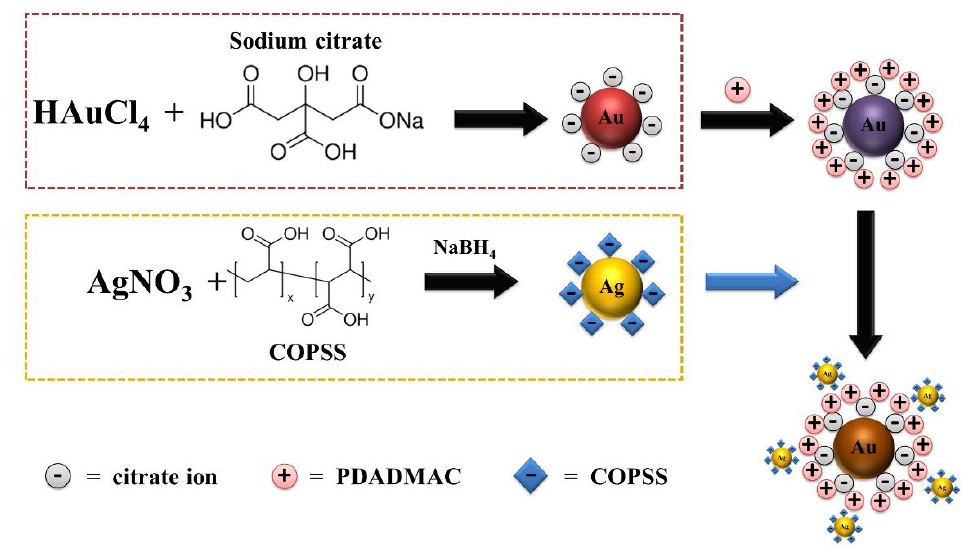
Scheme 1. Gold/silver bimetallic nanoparticles synthesized